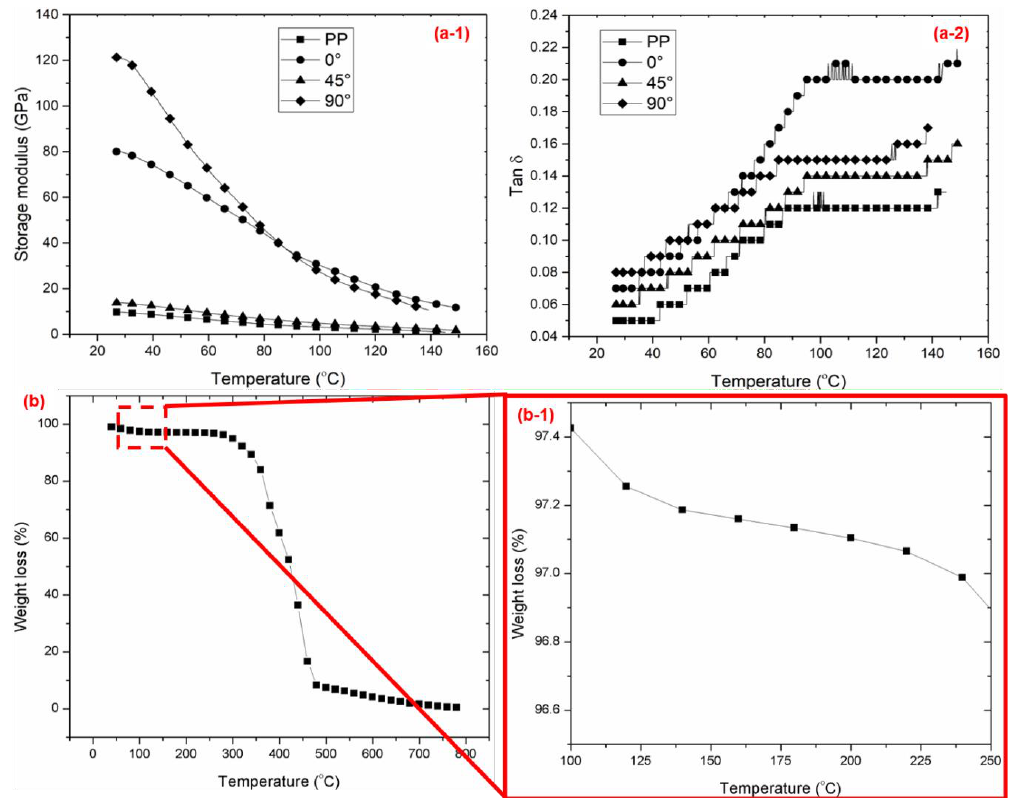
Figure 6. Dynamic mechanical analysis (DMA) of kenaf/PP composites. ( a1 ) Storage modulus and ( a2 ) tan δ at a temperature range of 30 and 150 °C, and ( b ) TGA of kenaf fibers; ( b1 ) enlarged image of ( b ).